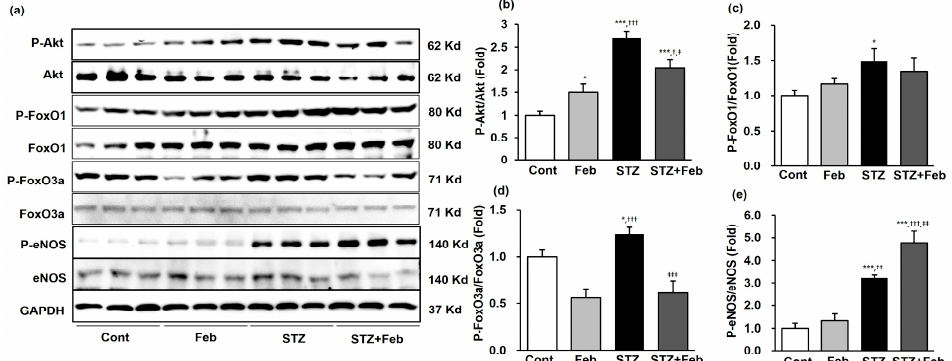
Figure 5. Representative images and quantitative analysis for Akt, FoxOs and eNOS expressions in STZ-induced diabetic mice with or without febuxostat treatment. ( a ) Representative immunoblot showing Akt, FoxOs and eNOS expression levels in mouse kidneys. ( b ) Quantitative analyses for phosphor-Ser 473 Akt/total Akt, ( c ) Quantitative analyses for phospho-Ser 256 FoxO1/total-FoxO1. ( d ) Quantitative analyses for phospho-Ser 253 FoxO3a/total-FoxO3a. ( e ) Quantitative analyses for phospho-Ser 1173 eNOS/total eNOS, * p < 0.05 and *** p < 0.001 vs. Cont, †† p < 0.01 and ††† p < 0.001 vs. Feb and ‡ p < 0.05, ‡‡ p < 0.01, and ‡‡‡ p < 0.001 vs. STZ group.